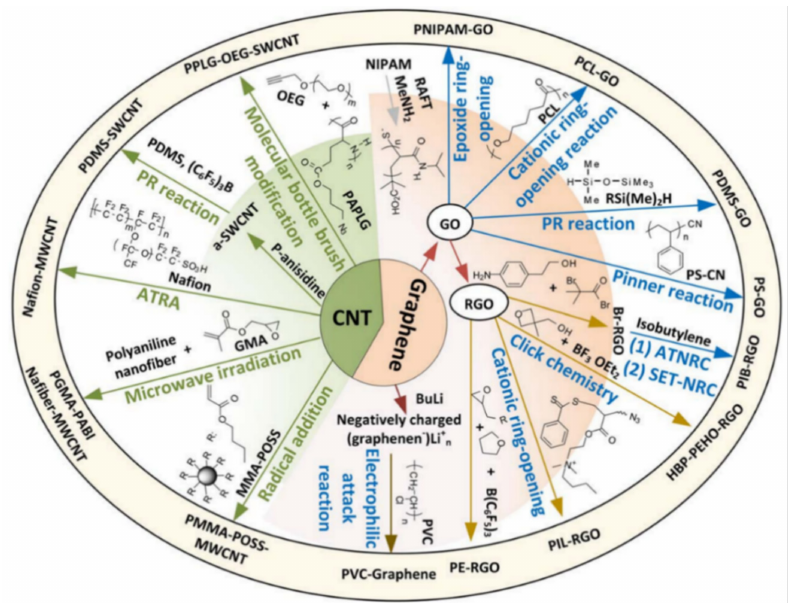
Figure 13. Covalent functionalization using the “grafting to” approach [105]. Reproduced with